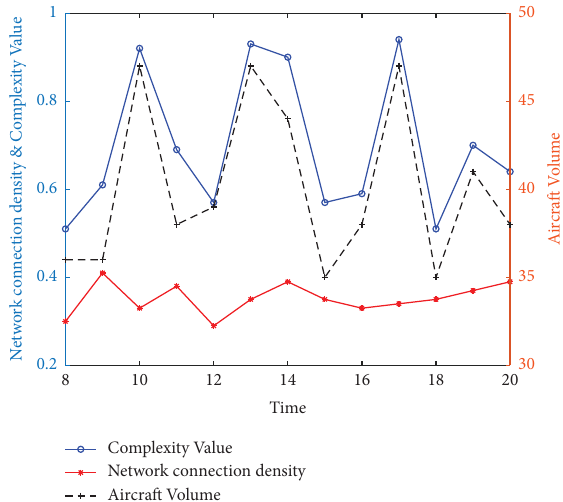
Figure 12: Complexity values, network connection density, and aircraft counts.